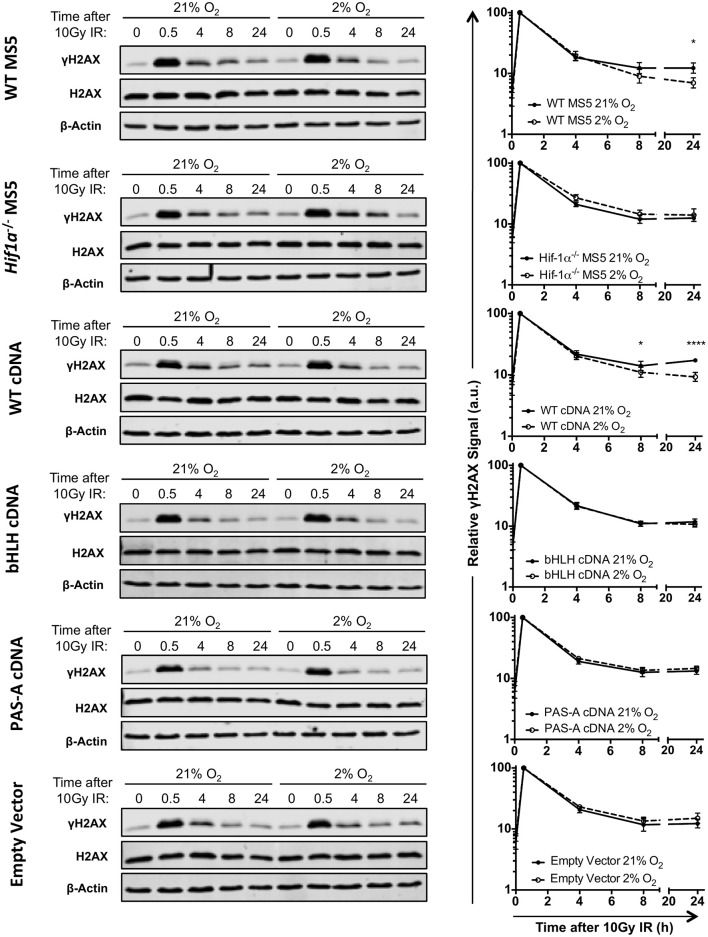
Effect of Hif-1α cDNA mutants on MS5 DSB repair kinetics. (Left) Representative western blots showing γH2AX, H2AX, and β-Actin levels in WT MS5 cell line, Hif1a
−/− MS5 Clone 41 cell line, and Hif1a−/− MS5 Clone 41 cell line transduced with and empty lentiviral vector, WT Hif1a cDNA bHLH-mutated Hif-1α cDNA and PAS-A-mutated Hif1a cDNA lentiviral constructs, cultured in 21 or 2% O2, 0–24 h after irradiation with 10Gy. (Right) Quantification of the relative γH2AX signal in the corresponding western blots, normalizing the signal against the 0.5 h timepoint (peak of the γH2AX signal) and using both H2AX and β-Actin as loading controls. *p < 0.5, ****p < 0.0001, two-way ANOVA with Bonferroni post-test correction, n = 4.